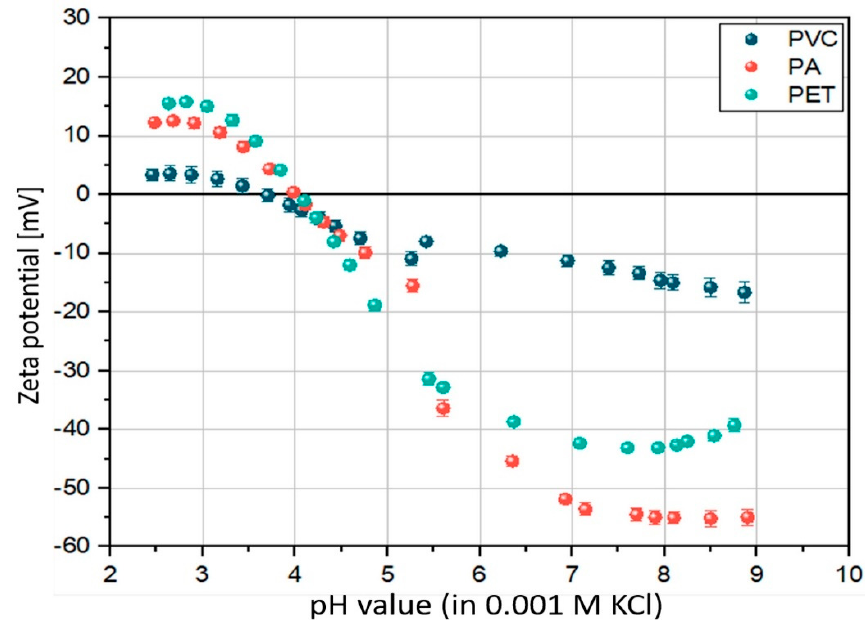
Figure 1. Zeta potential values of the three polymers versus pH value. The zeta potential was measured for polyvinyl chloride (PVC) (blue), polyamide (PA) (red), and polyethylene terephthalate (PET) (green) via pH titration in 0.001M KCl. Values indicate means ± standard error of the mean.